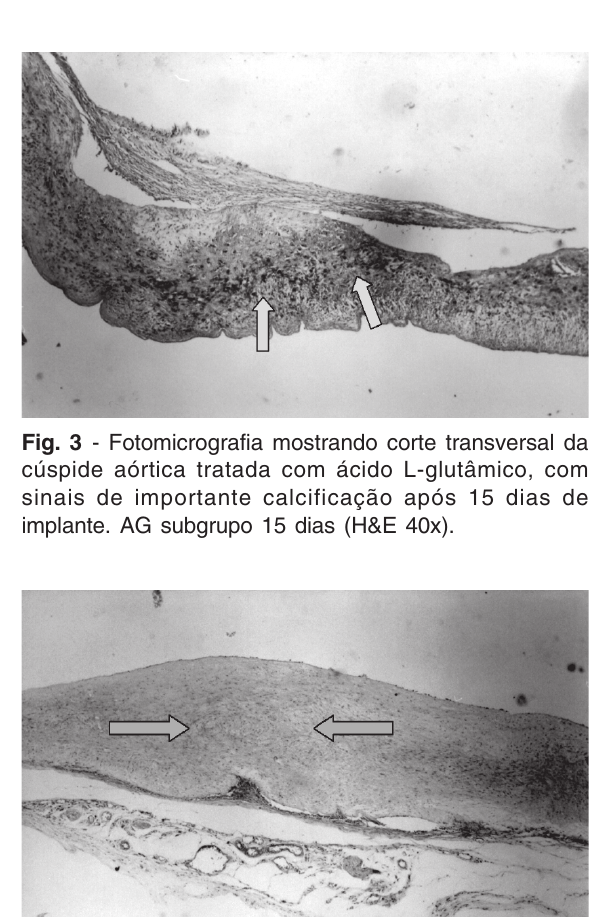
Fig. 2 - Fotomicrografia mostrando corte transversal da cúspide aórtica tratada com glutaraldeído, com sinais de importante calcificação após 30 dias de implante. GDA subgrupo 30 dias (H&E 100x).